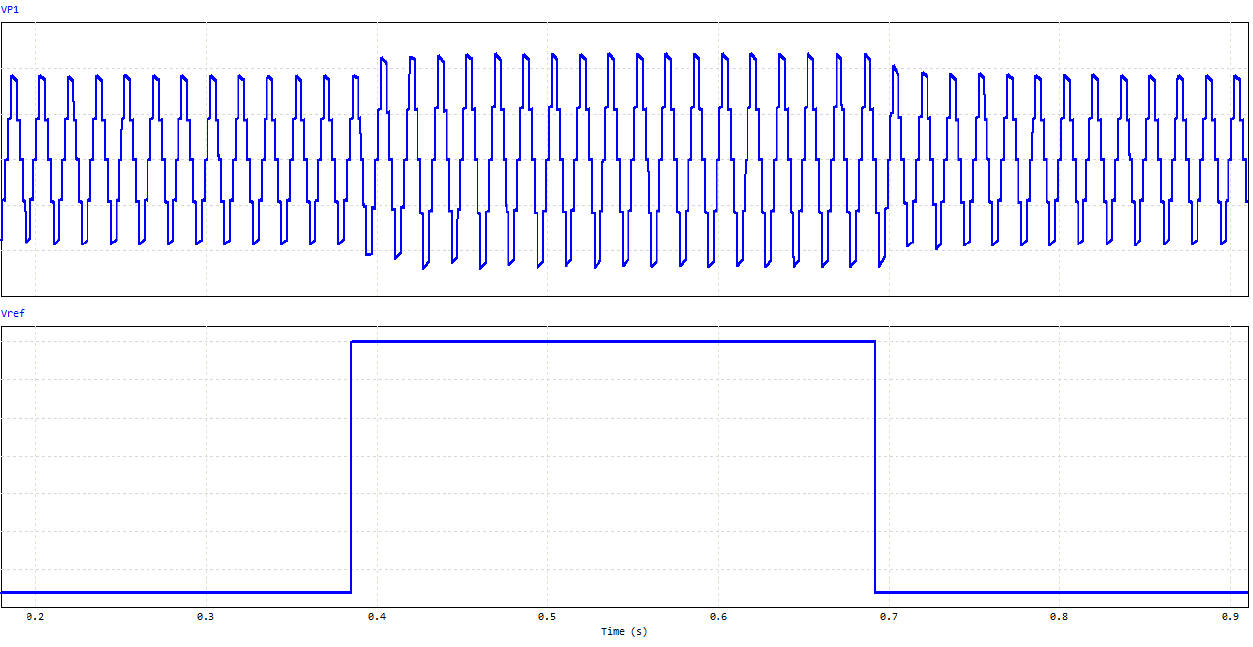
Figure 28. Operation of the converter under closed-loop control. Output voltage waveform when the control reference is changed from 127 to 160 V RMS .